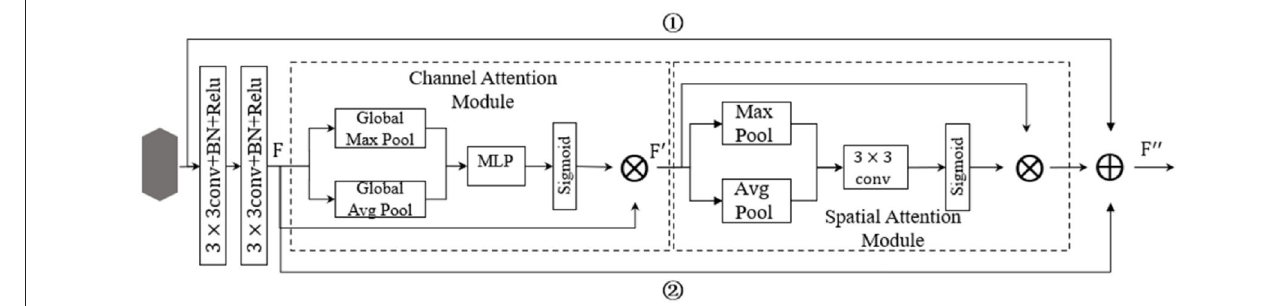
FIGURE 14 | Residual attention layer (RAL) structure.